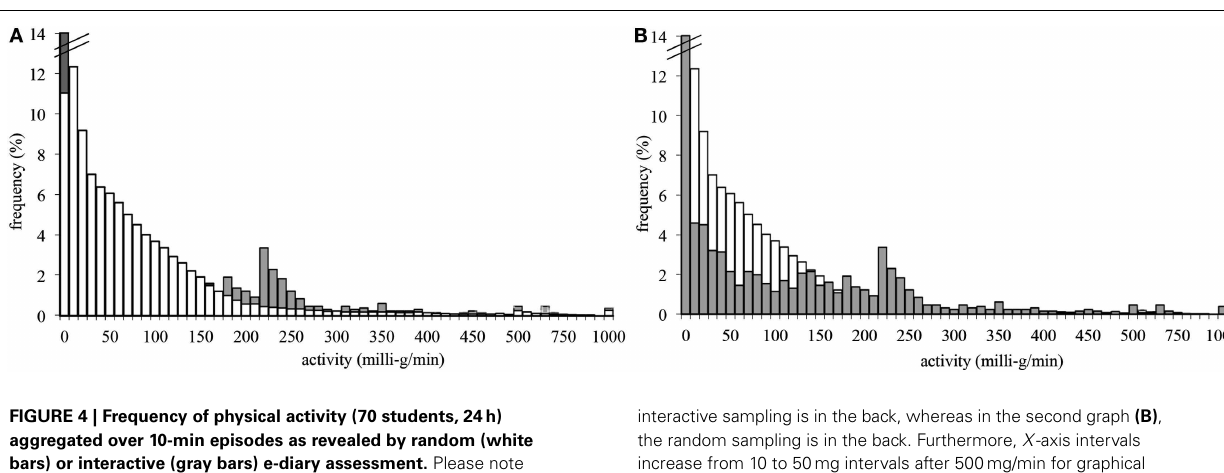
interactive sampling is in the back, whereas in the second graph (B) , the random sampling is in the back. Furthermore, X -axis intervals increase from 10 to 50mg intervals after 500mg/min for graphical